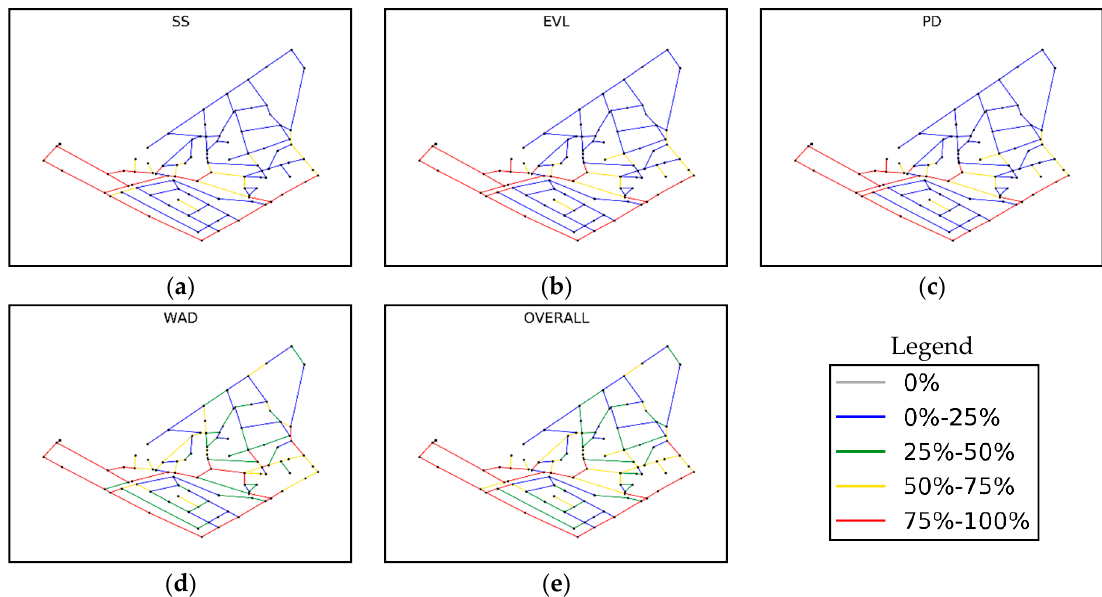
Figure 4. Critical pipe assessment for ( a ) supply shortage ( SS) , ( b ) economic value loss ( EVL) , ( c ) pressure decline ( PD) , ( d ) water age degradation ( WAD) , and ( e ) OVERALL of Network 2.